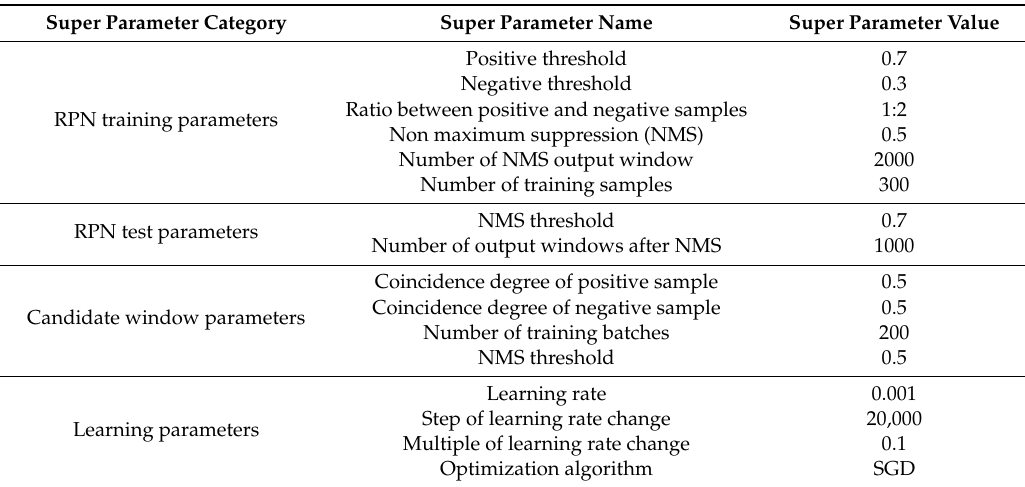
Table 1. Hyper parameters